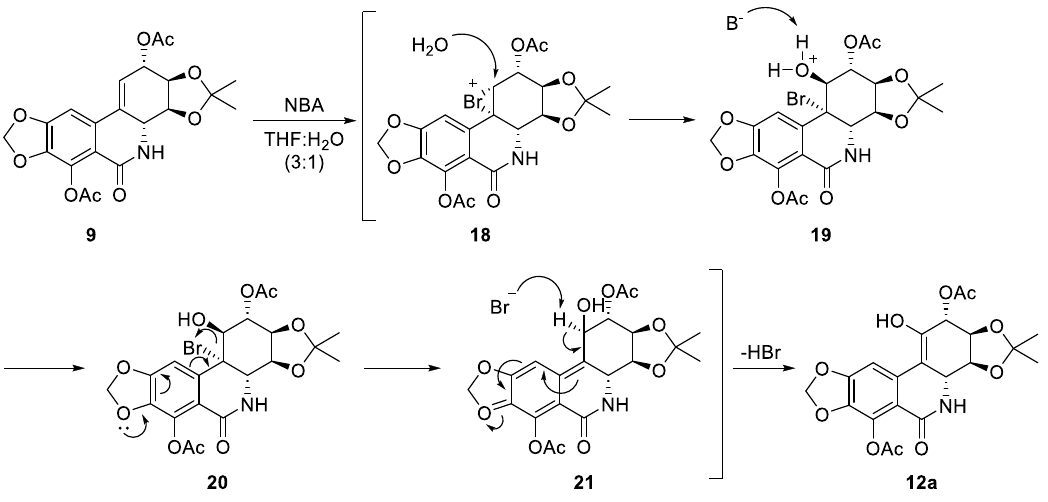
Figure 2. Suggested mechanism for the formation of C-1 enol.